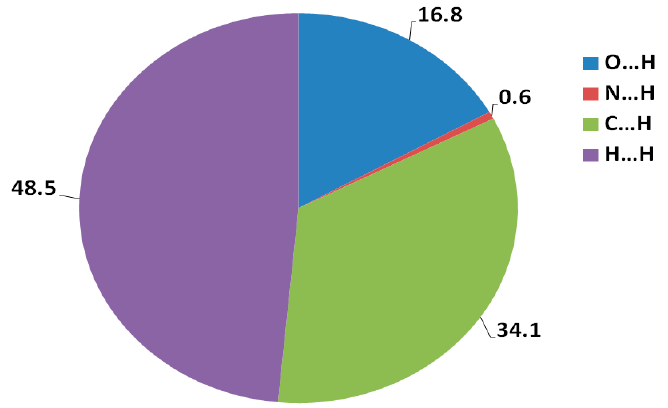
Figure 5. Percentages of the intermolecular interactions in the aza-Michael product 3 crystal structure.